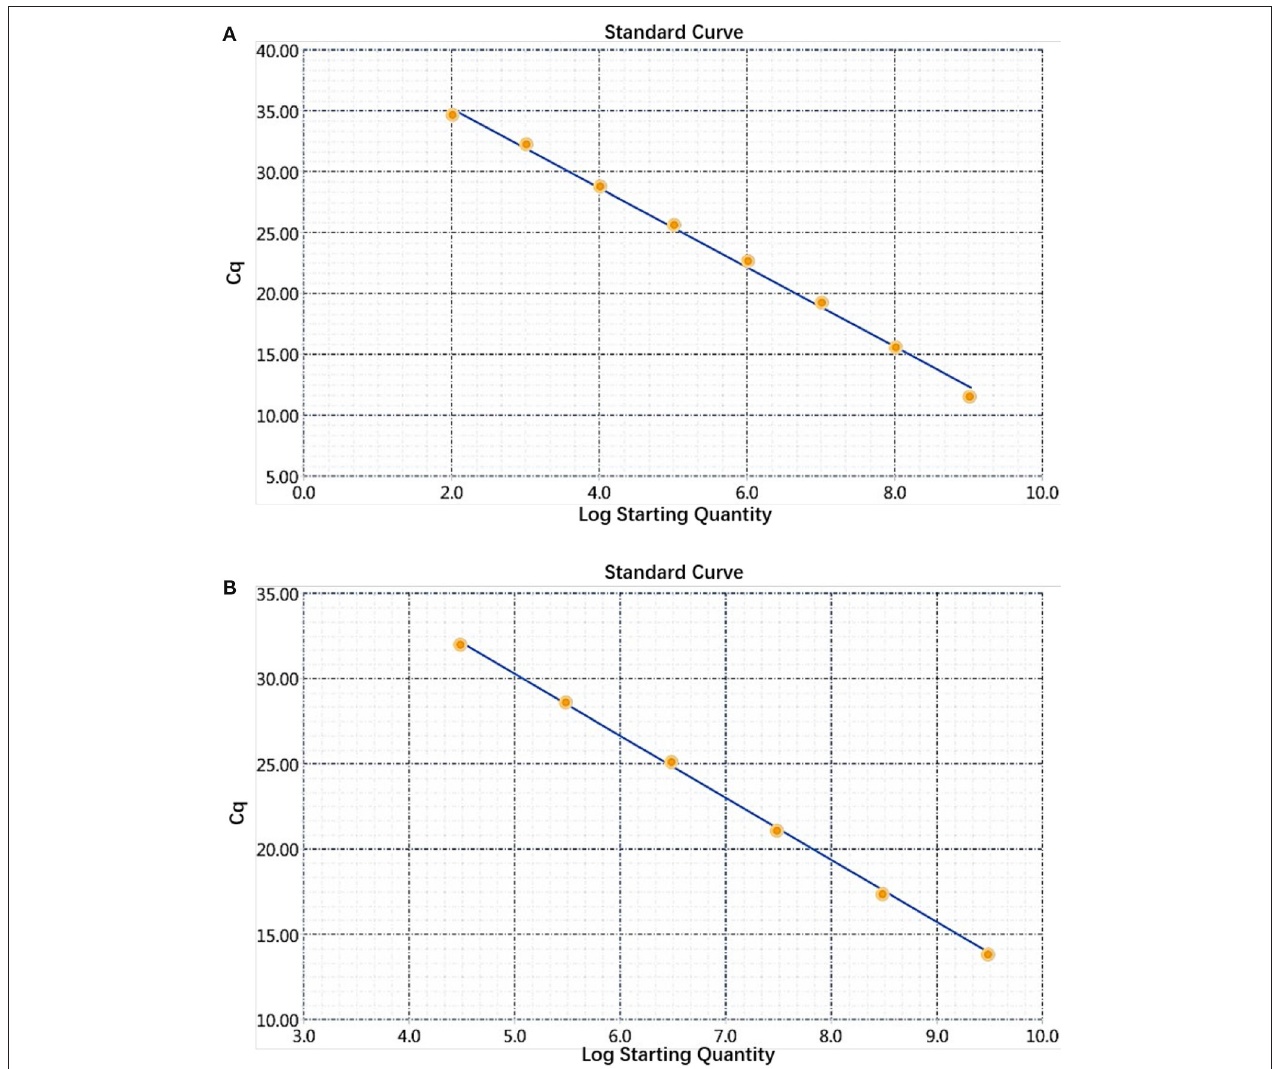
FIGURE 6 | Establishment of a dual real-time PCR standard curve. (A) Standard curve for plasmid pUC57- B646L , y = − 3.258x + 41.69, R 2 = 0.994. (B) Standard curve for plasmid pCAGGS- E183L , y = − 3.639x + 48.47, R 2 =